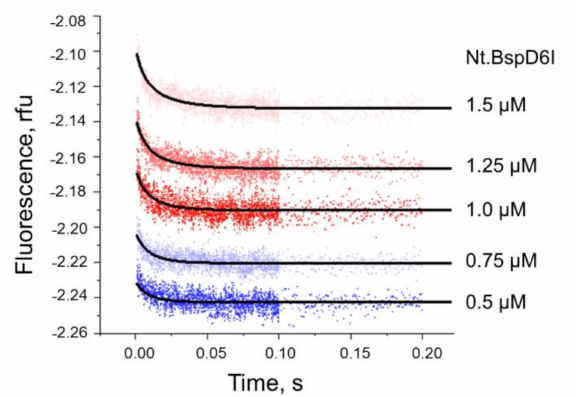
Figure 9. Kinetic curves for the interaction of Nt.BspD6I (concentration is indicated to the right of the curves) with 1 µ M duplex II-19C in the presence of 10 mM CaCl 2 . Coloured dots indicate experimental data, and solid curves denote calculated kinetic curves conforming to Scheme 1. Table 5. Parameters of the interaction of Nt.BspD6I with DNA duplex II-19C or II-19D . Constants